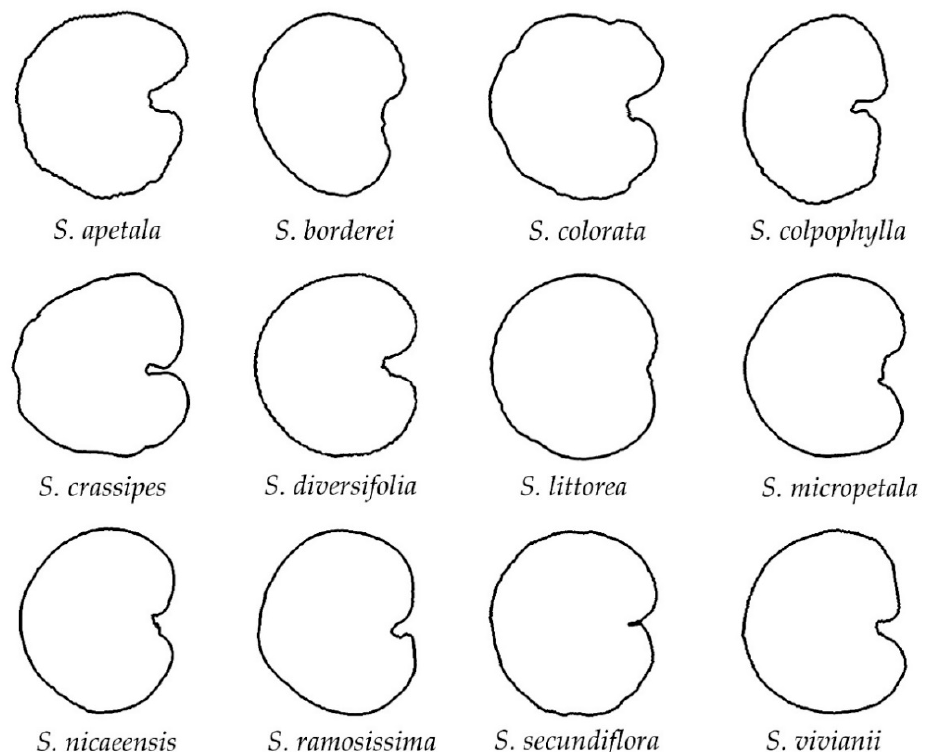
Figure 2. Silhouettes of the lateral views of Silene seeds belonging to the group of smooth seeds.